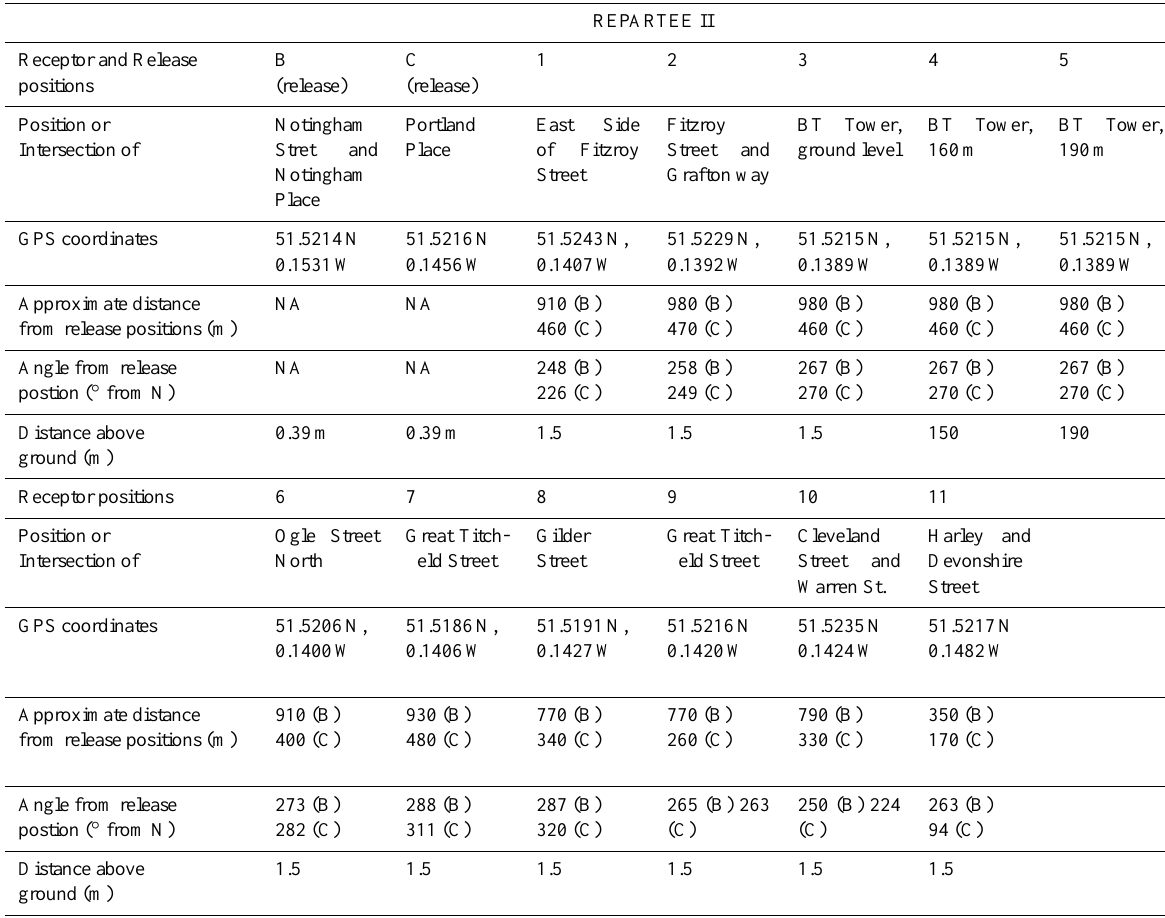
Table 1b. Experimental details for REPARTEE